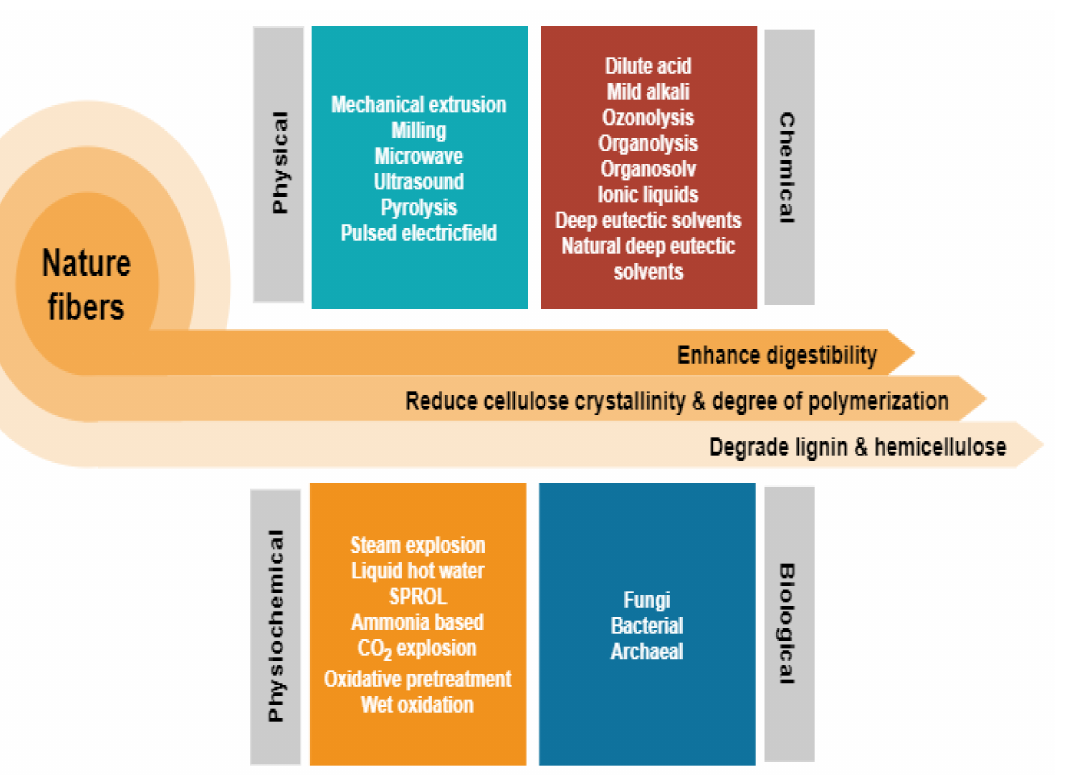
Figure 2. Different pretreatments, which fall into four main categories: physical, chemical, biological, and combination have been used to improve lignocellulosic fractionation for natural